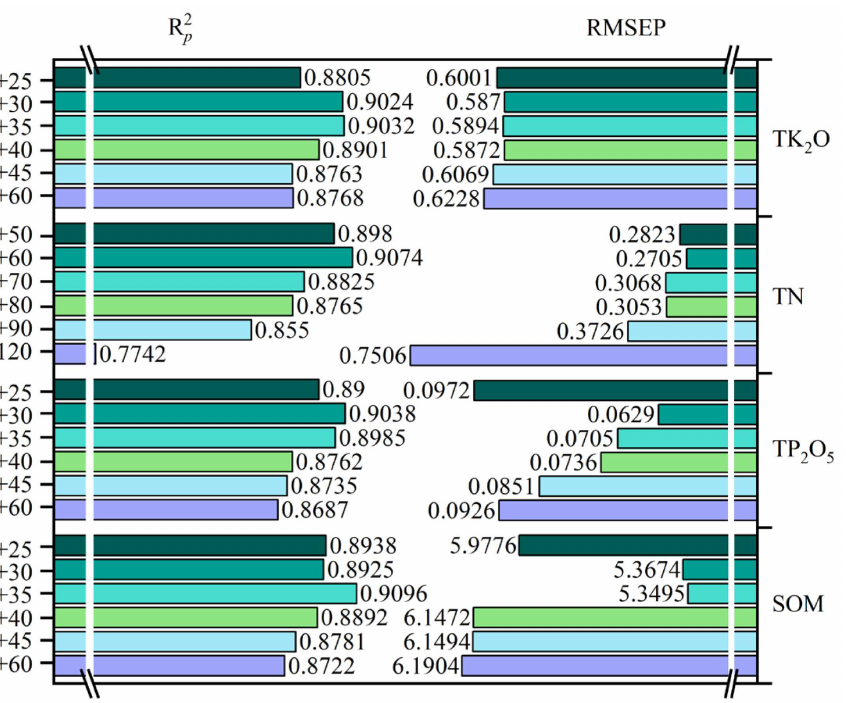
Figure 9. More detailed analysis of the impact of GAN-generated data on CNN models for the four